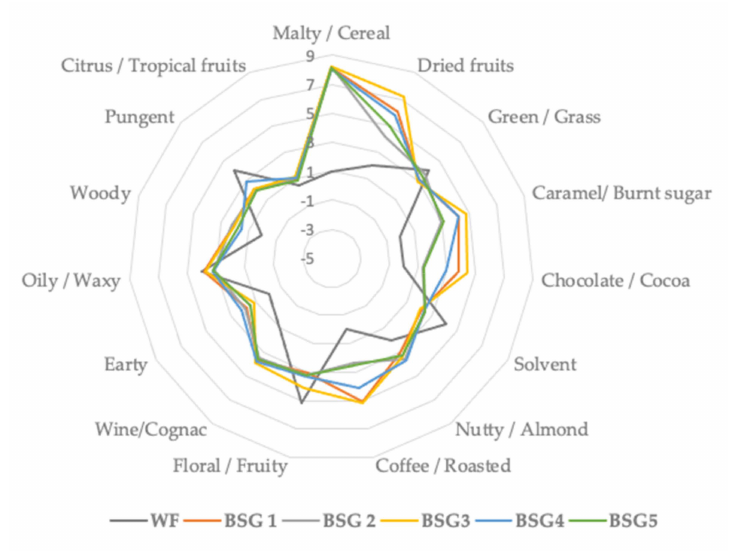
Figure 2. Aroma profile of wheat flour (WF) and different BSG (brewers spent grains) types of main compounds classes identified during GC-MS